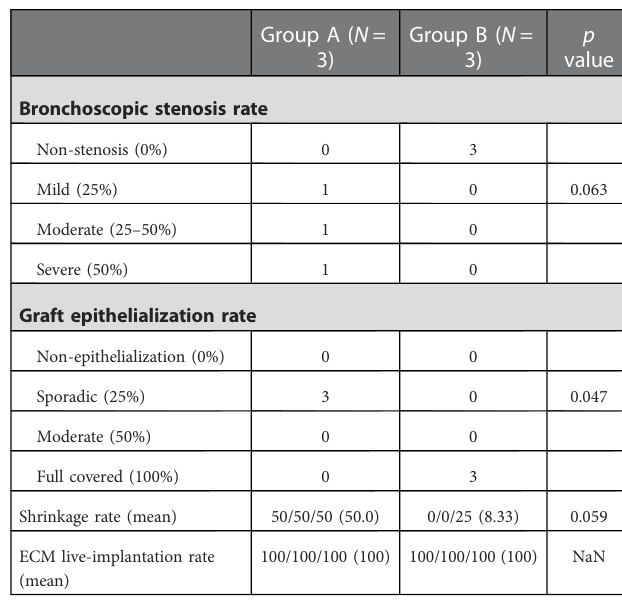
TABLE 1 Comparison of stenosis rates, etc. between parallel and perpendicular group. There was a signi fi cant difference between the two groups in graft epithelialization rate. There were no signi fi cant differences in other parameters such as shrinkage rate between the two groups.